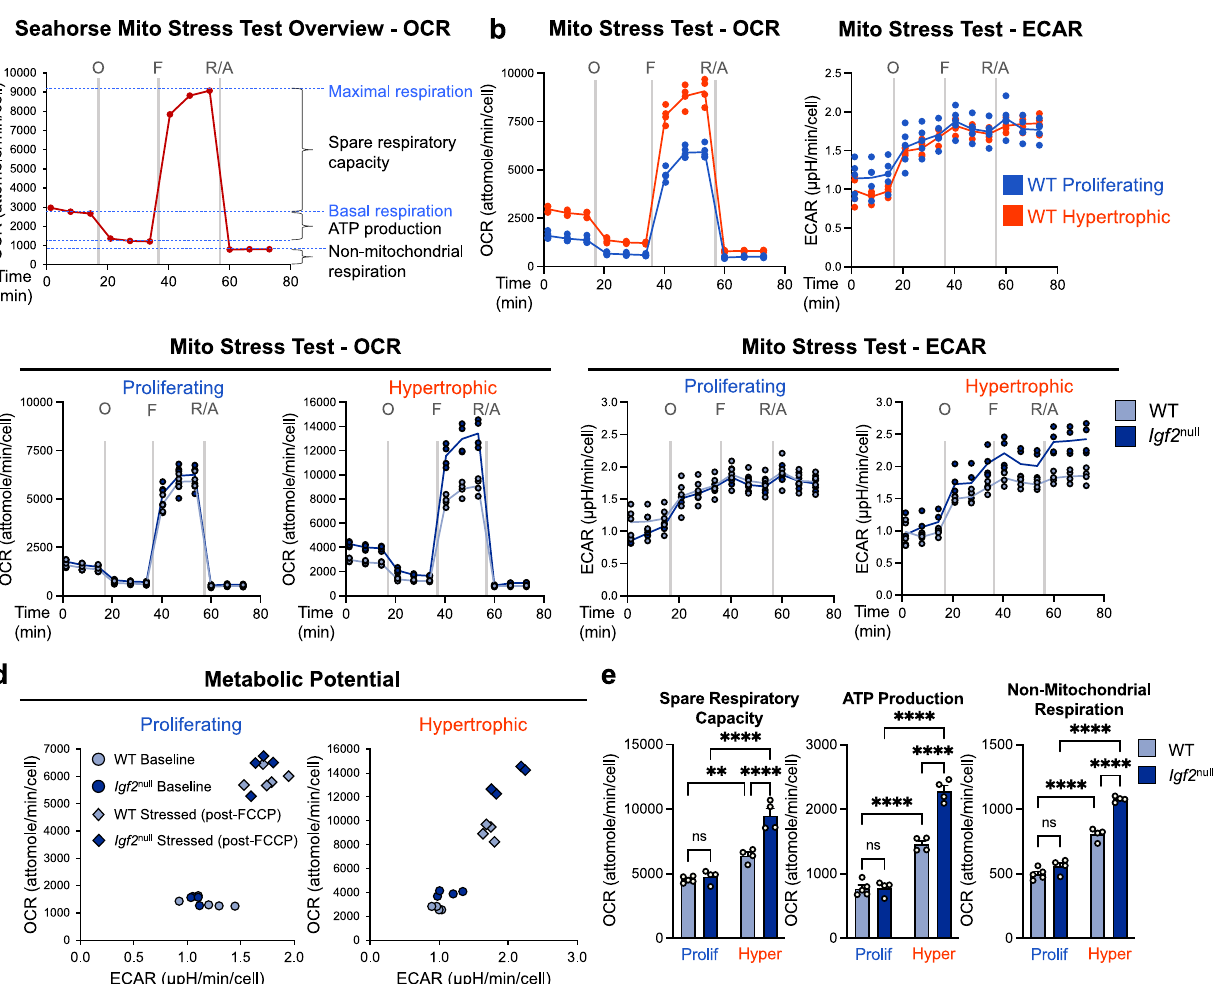
Fig. 2 Hypertrophic differentiation is characterized by a marked increase in oxidative phosphorylation that is further exacerbated by Igf2 de fi ciency. a Schematic of expected oxygen consumption rate (OCR) readings for a Mito Stress Test in the Seahorse XFe96 metabolic analyzer, including injection points for oligomycin (O), FCCP (F), and rotenone/antimycin A (R/A). b Metabolic analysis: OCR and extracellular acidi fi cation rate (ECAR) of WT epiphyseal chondrocytes under proliferative and hypertrophic conditions. Note that the OCR curve for WT hypertrophic chondrocytes also appears in ( a ). c OCR and ECAR analyses of WT and Igf2 null epiphyseal chondrocytes under proliferative and hypertrophic conditions. Note that the WT lines in ( c ) are the same as those in ( a ) and ( b ). d Metabolic potential of WT and Igf2 null epiphyseal chondrocytes at baseline and after being stressed (post-FCCP injection). e Spare respiratory capacity, (mitochondrial) ATP production, and non-mitochondrial respiration as calculated from OCR measurements. Data are presented as individual measurements with a line indicating the mean where necessary ( b , c , d ) or individual measurements with mean + SEM ( e ), representative of n = 5 experiments with 3 – 6 wells per group. Statistical signi fi cance was calculated using a two-way ANOVA with Tukey ’ s test for multiple comparisons ( e ). p -values indicated as ns (not signi fi cant), * p < 0.05, ** p < 0.01, *** p < 0.001, **** p <